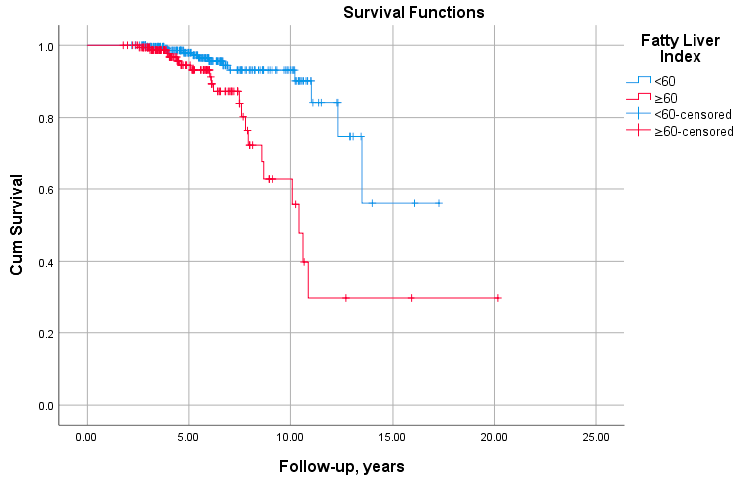
Figure 3. Kaplan–Meier survival curve as stratified by fatty liver index (FLI). FLI ≥ 60 was associated with significantly reduced event-free survival from type 2 diabetes (log-rank = 15.46, p = 0.001).